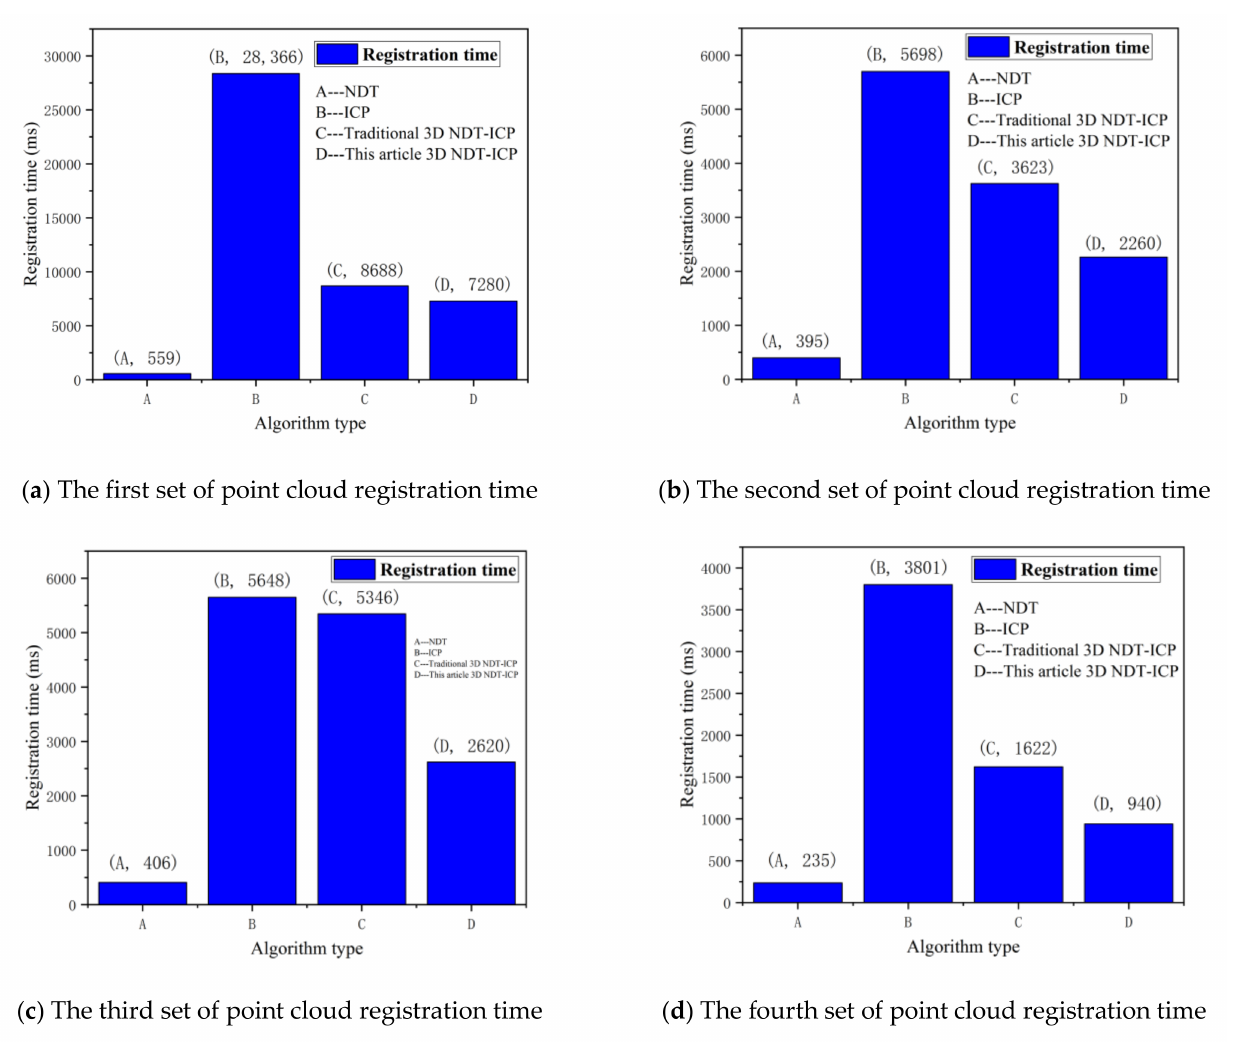
Figure 12. Point cloud registration